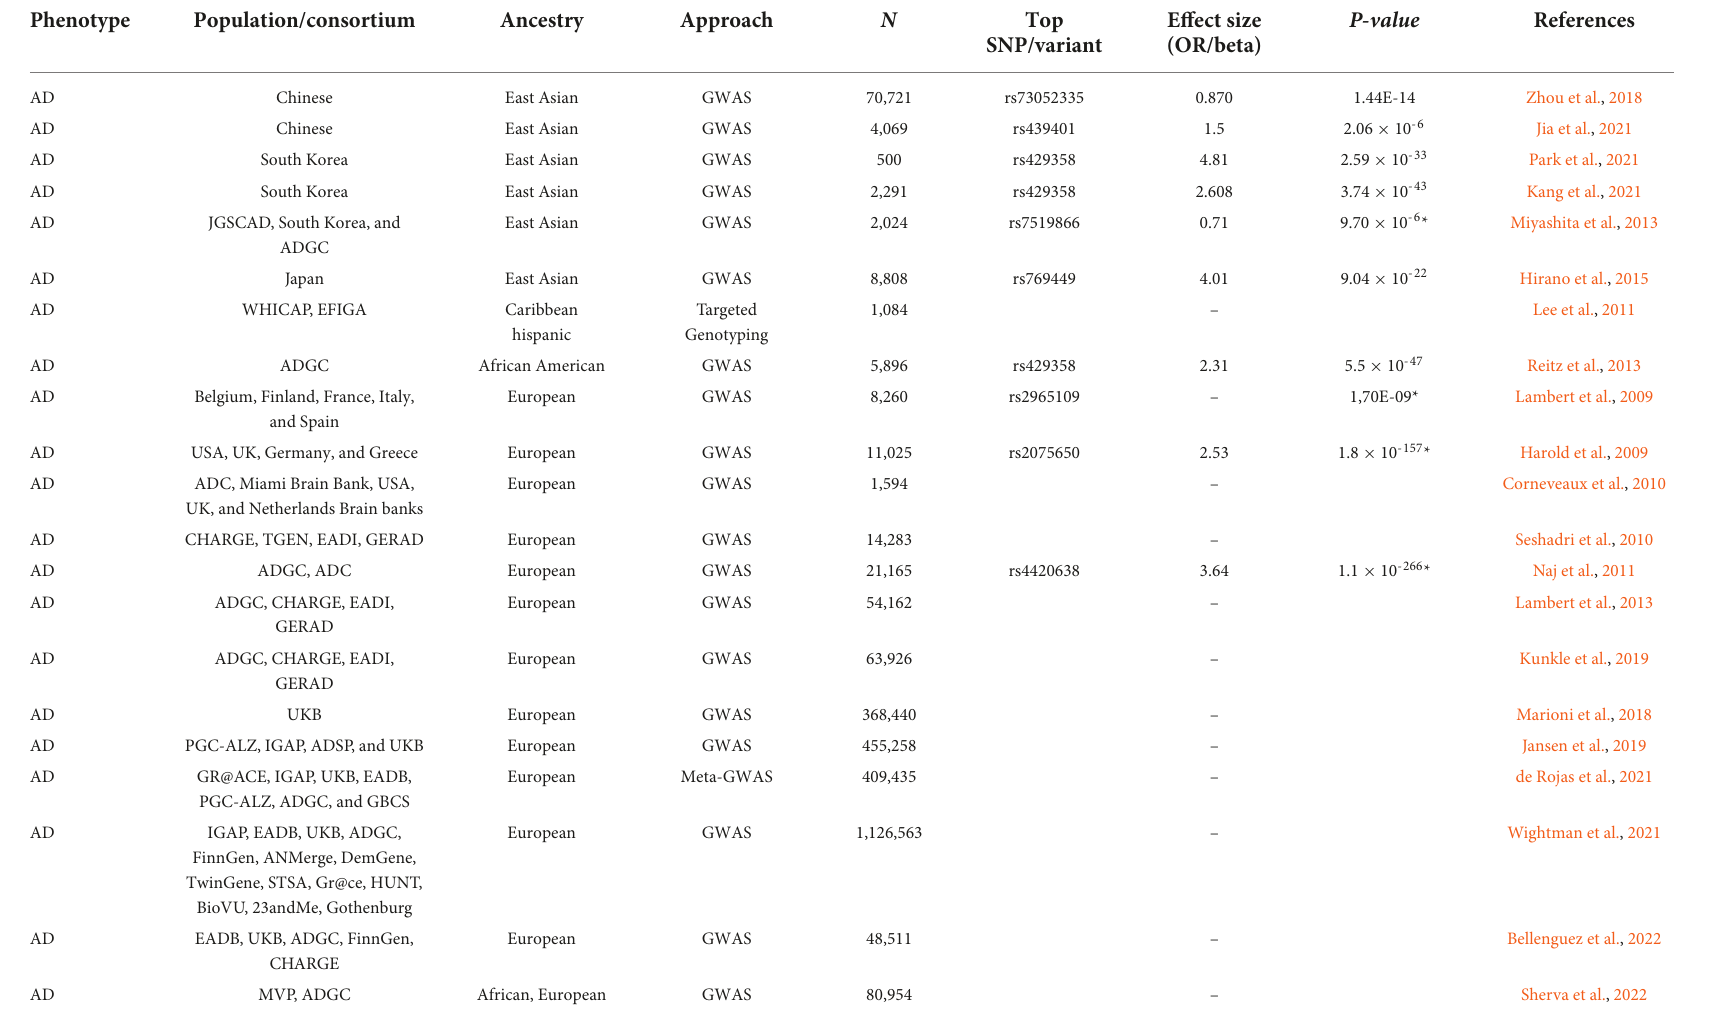
TABLE 2 Summary of APOE locus genetic association with neurodegenerative disease across global